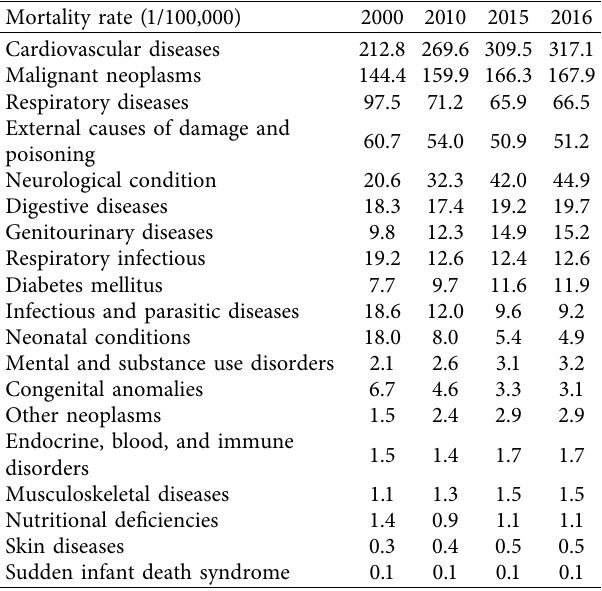
Table 3: Demographic mortality statistics in China based on the WHO